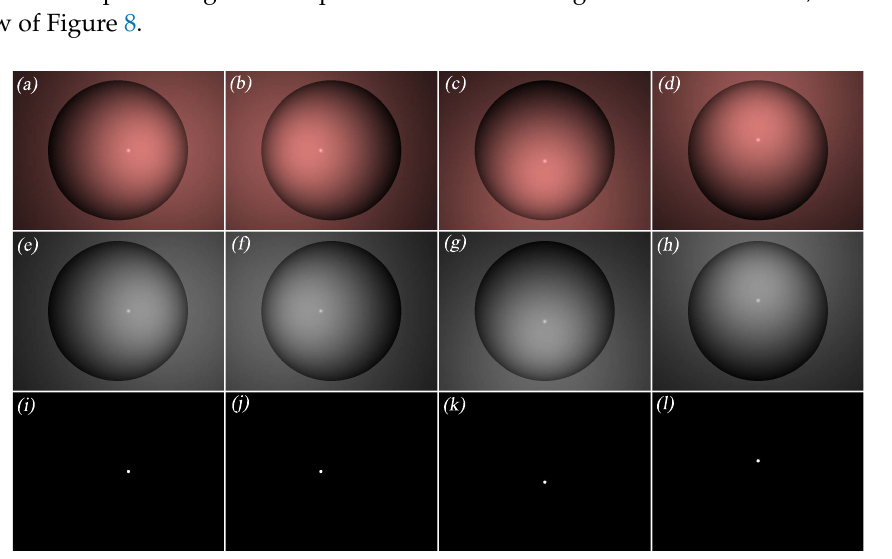
Figure 8. Photometric stereo images, illuminance maps, and detected specular highlight regions in the simulation environment. ( a – d ): generated photometric stereo images in the simulation environment. ( e – h ): illuminance maps of the photometric stereo images in the simulation environment. ( i – l ): detected specular highlight regions in the simulation